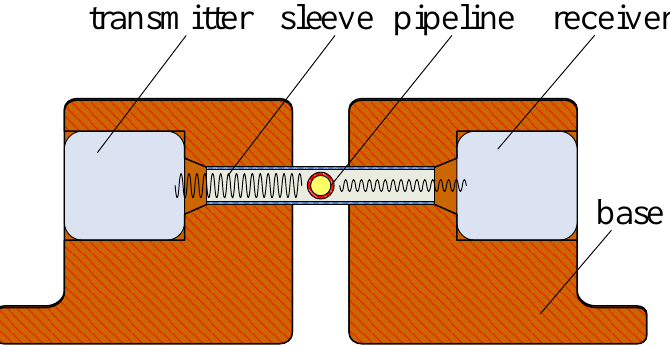
Figure 1. The structure of probe (section plane).